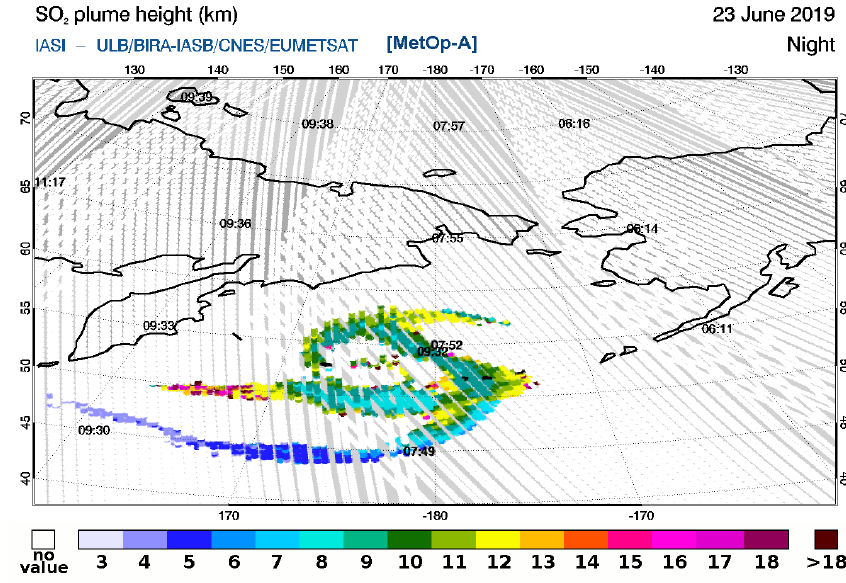
Figure 3. Characterisation of Raikoke plume by SO 2 layer height from IASI-A on 23 June